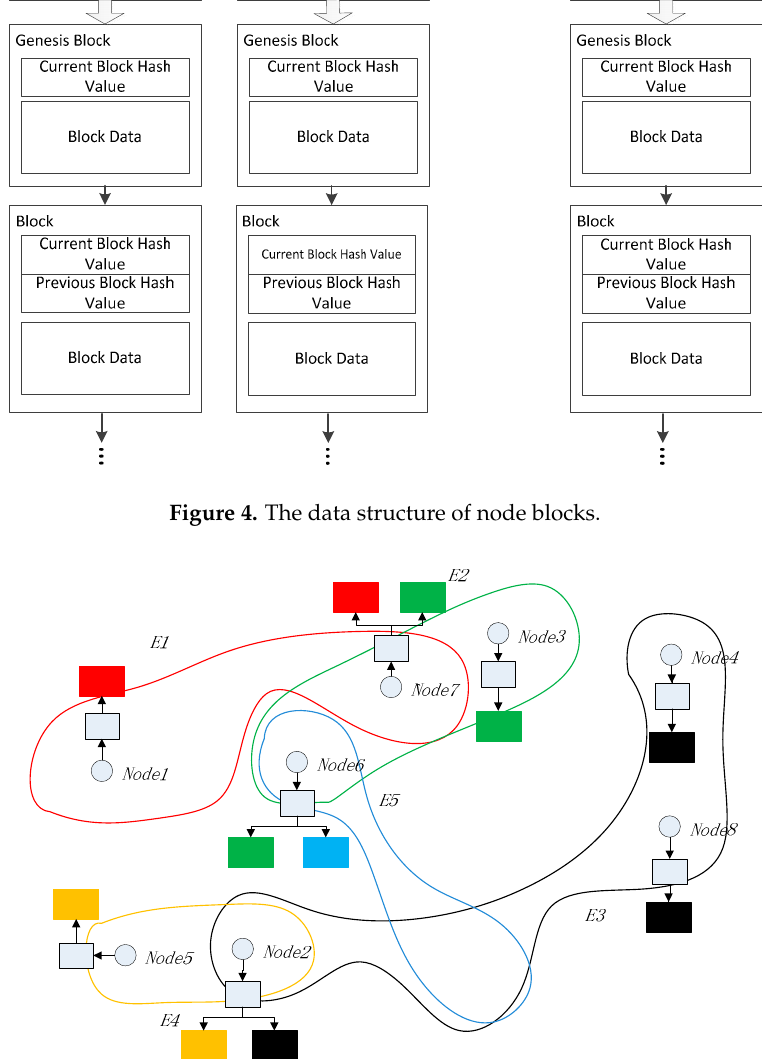
Figure 5. The data model of a hypergraph-based blockchain network.